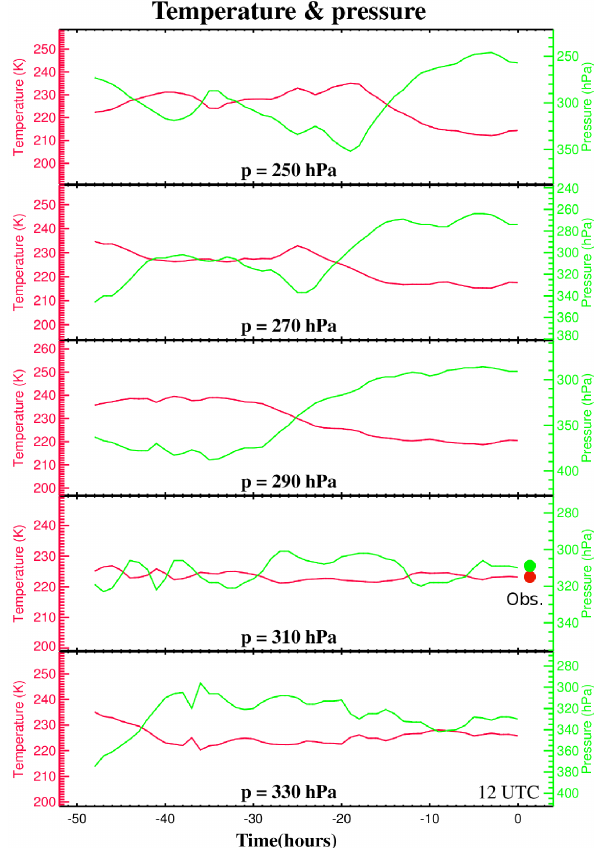
Fig. 10. Temperature and pressure along the trajectories shown in Figure 9, ending at the point of contrail detection at 310 hPa. In the 310hPa panels, big dots denotes the observations (see Figs. 5 the 310 hPa panels, big dots denotes the observations (see Figures 5 and and 6).